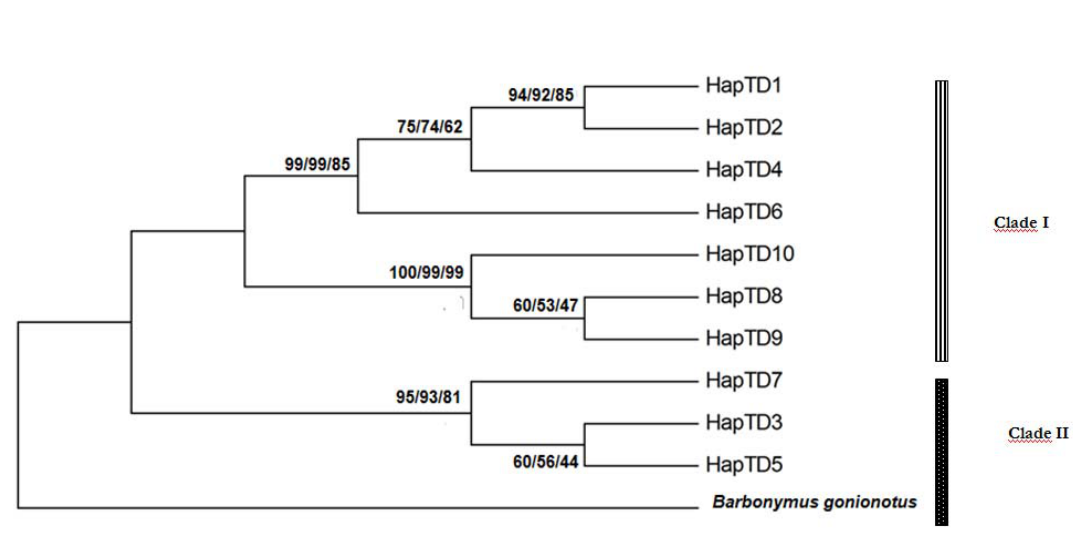
F IGURE 2. Maximum likelihood, Maximum Parsimony/Neighbour Joining dendogram showing the relationship between COI haplotypes. The number at each node represents the bootstrap proportions (%) based on 1000 pseudo replications for Maximum likelihood/Maximum Parsimony/Neighbour Joining